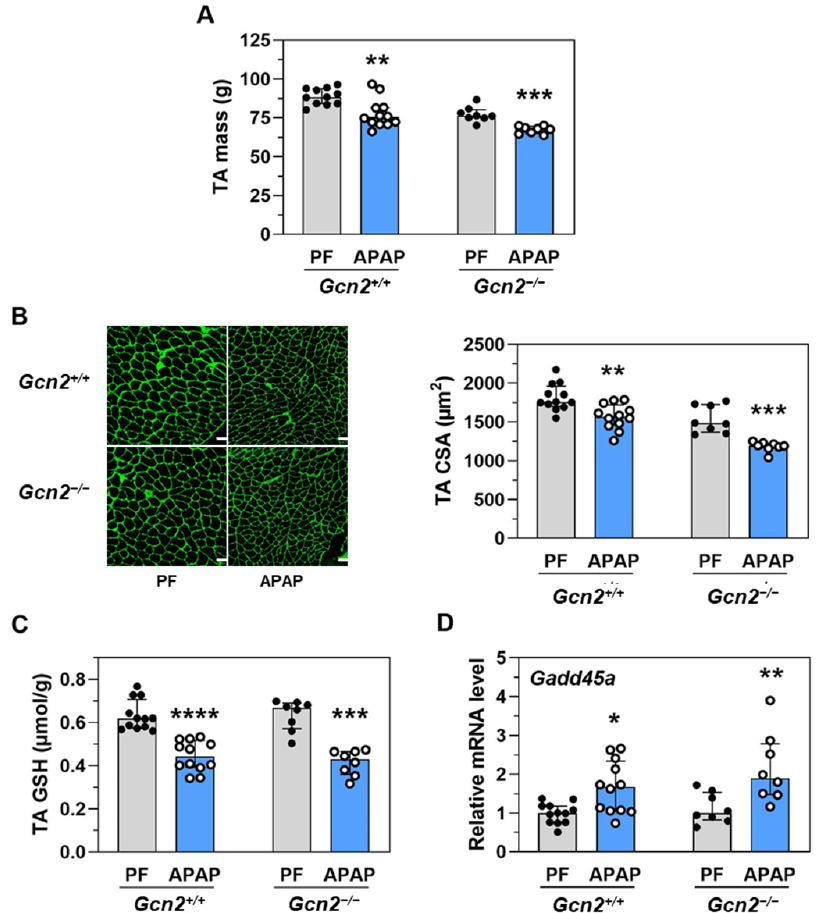
Figure 5. Impact of the absence of GCN2 on the response of the tibialis anterior (TA) muscle to APAP treatment for 18 d. Gcn2 null ( Gcn2 − / − ) or positive mice ( Gcn2 +/+ ) were fed a diet with 1% APAP (APAP) for 18 d or were pair-fed (PF) the respective control diet to match the level of food intake of the APAP-treated mice. ( A ) Mass of the two TA muscles. ( B ) Cross-sectional area (CSA) of muscle fibers. Scale bar = 50 µ m. ( C ) Total free GSH (GSH, GSSG, and other small disulphides) concentration in TA muscle. ( D ) Expression of the ATF4-dependent gene Gadd45 . Total RNA extracted from the liver was analyzed by reverse transcription RT-qPCR. Each bar shows the median with interquartile and dots are individual values. * p ≤ 0.05; ** p ≤ 0.01; *** p ≤ 0.001; **** p ≤ 0.001 vs. respective PF; Mann Whitney